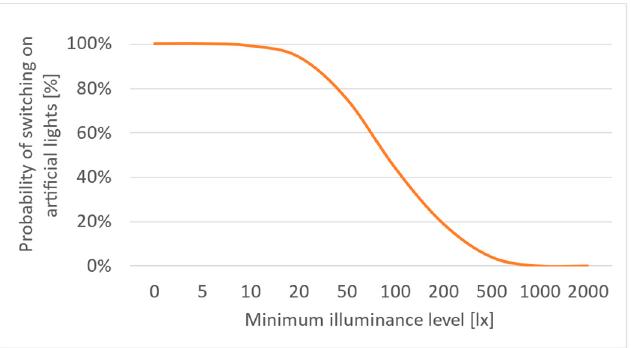
Figure 5. Probability of switching on artificial lights as a function of illuminance level [11].